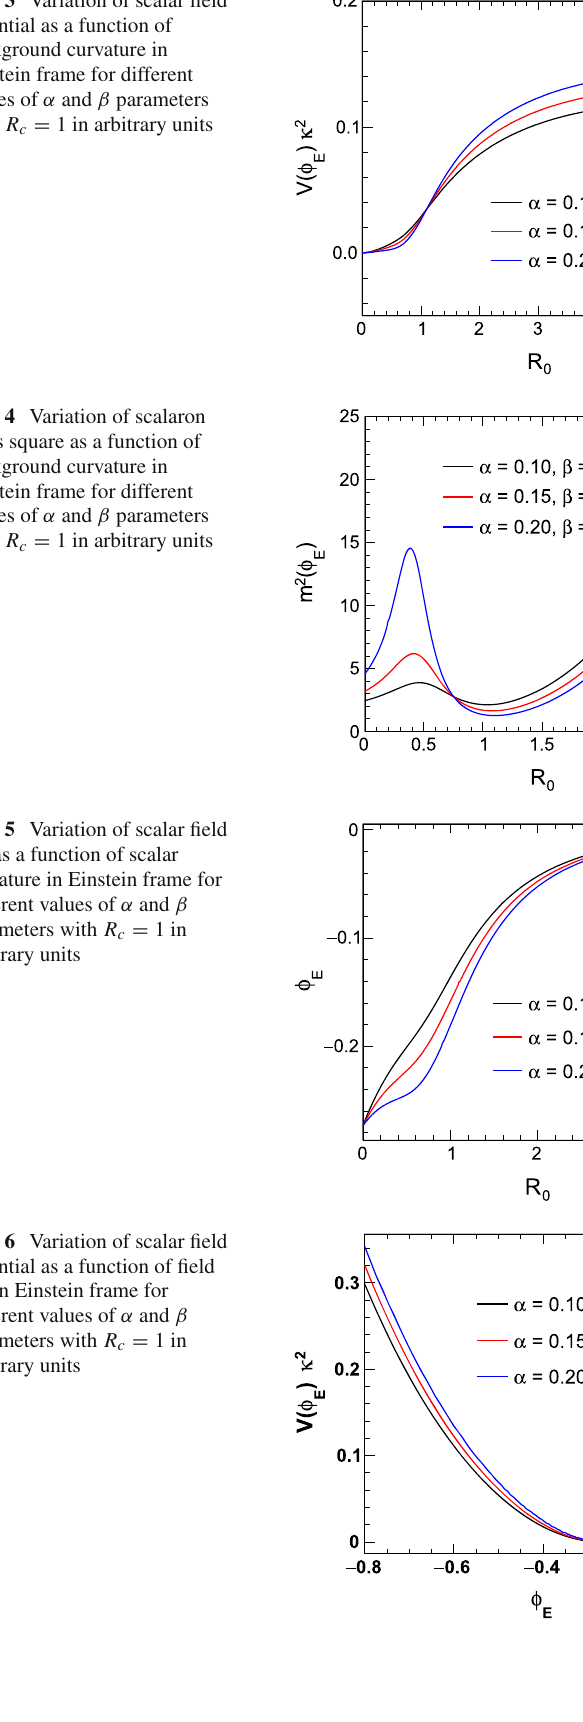
Fig. 3 Variation of scalar field potential as a function of background curvature in Einstein frame for different values of α and β parameters with R c = 1 in arbitrary units